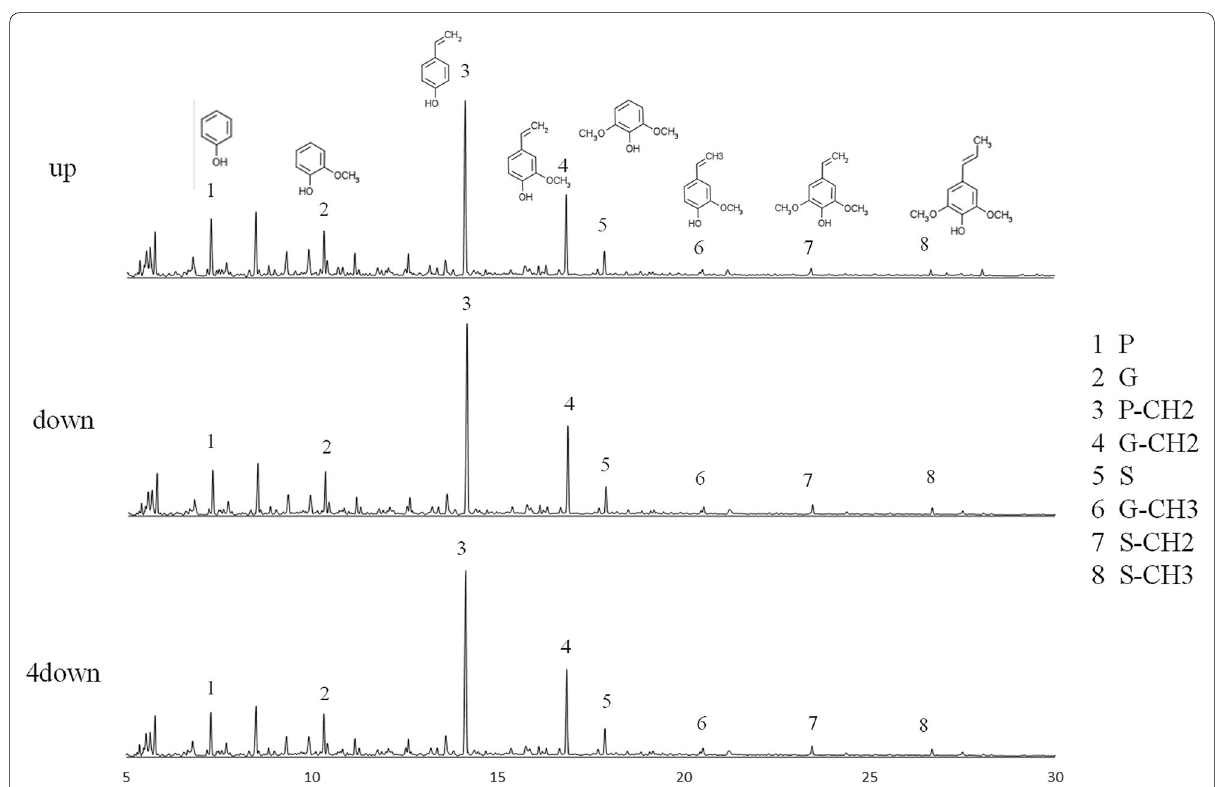
Fig. 3 Results of the Py‑GC analysis of the “Uradome” upper and lower sections. Pyrolysis products derived from H‑type, G‑type, and S‑type identified by Py‑GC in the upper and lower “Uradome”